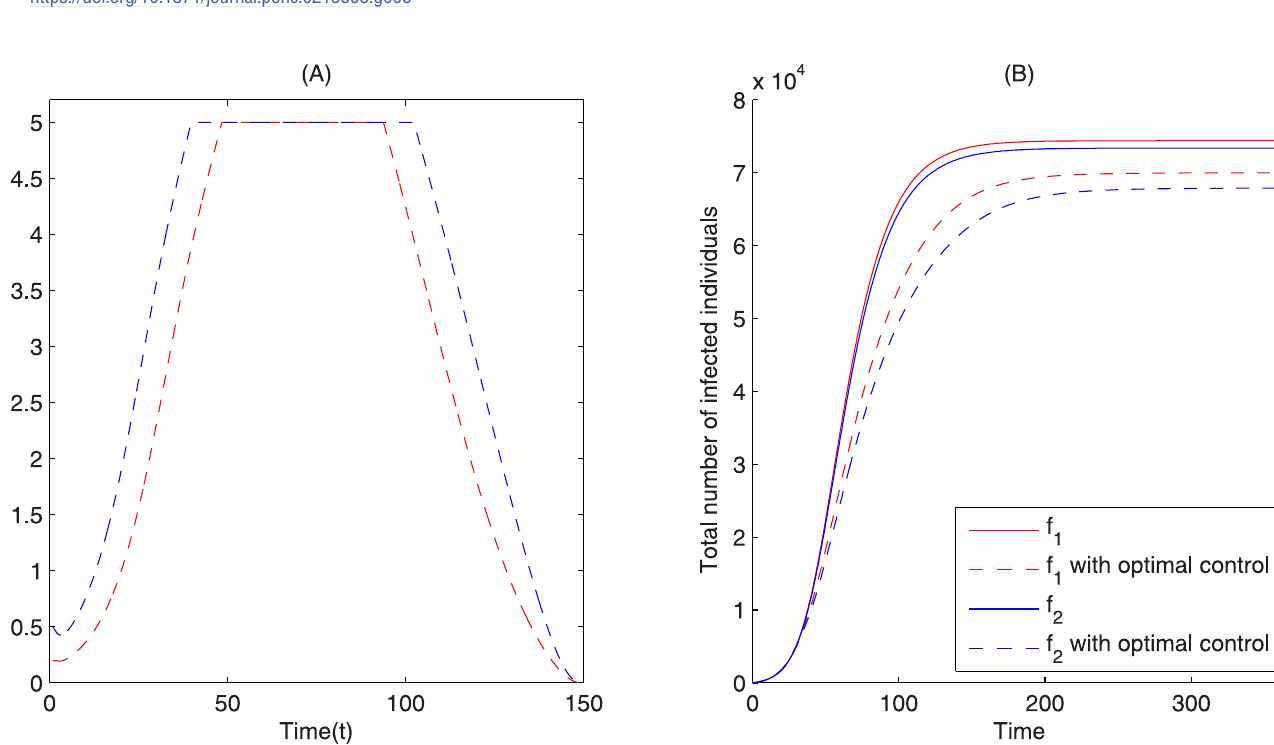
PLOS ONE | https://doi.org/10.1371/journal.pone.0213898 March 21,